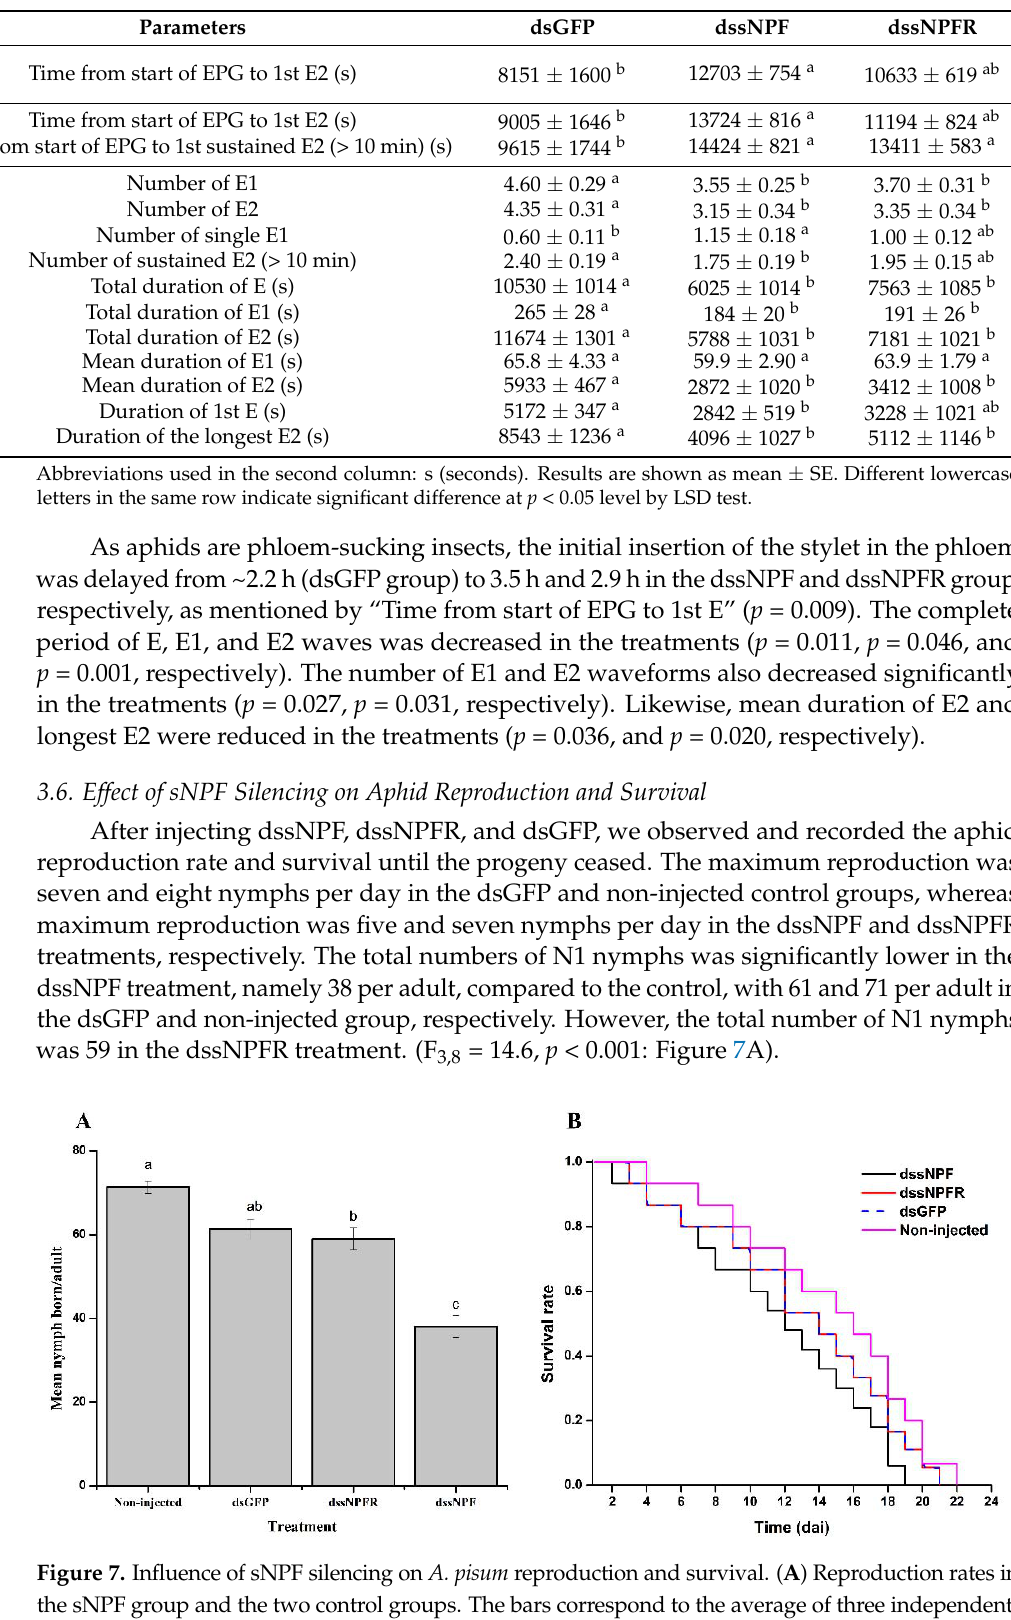
Table 2. Comparison of feeding behaviors related to phloem activity of A. pisum in the dssNPF and dssNPFR treatments, as well as dsGFP control groups, on broad bean seedlings.